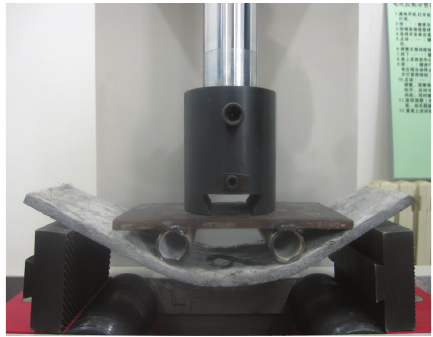
Figure 1: Four-point bending test of plain PP ECC.